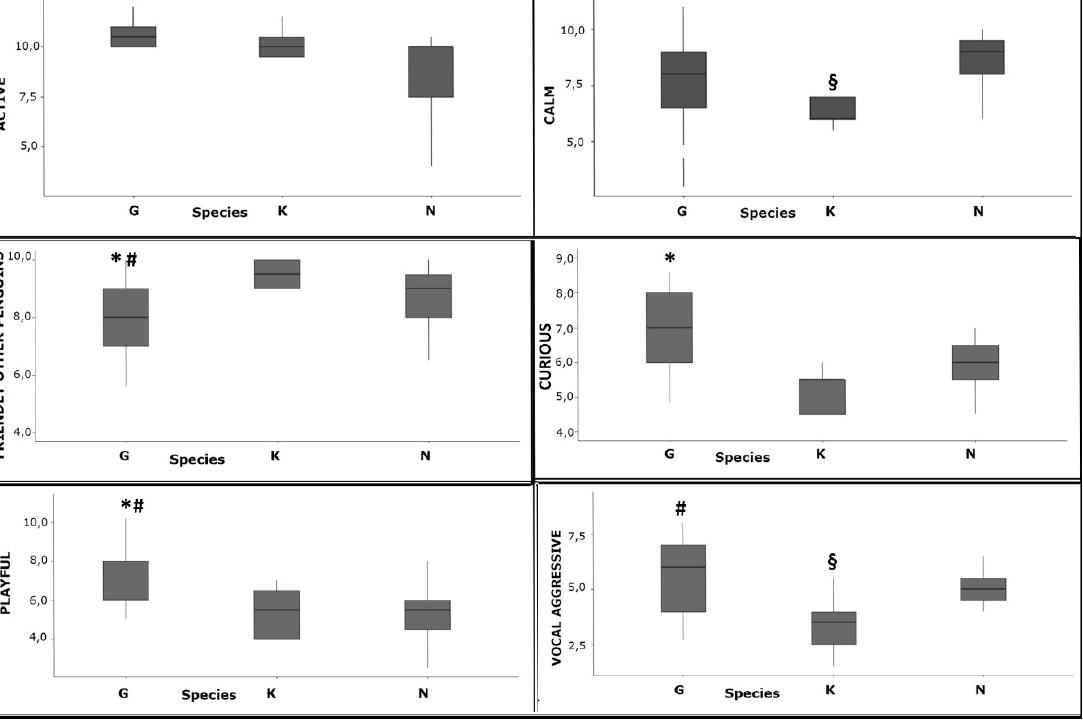
Table 3. Dwass-Steel-Critchlow-Fligner (DSCF), test for multiple comparisons analysis of the differences between the median values of the personality traits, rated by the keepers, in the three species of penguin. W = Wilcoxon rank sum test statistic; p < 0.05 values are considered as statistically different. Only statistically different results are listed.